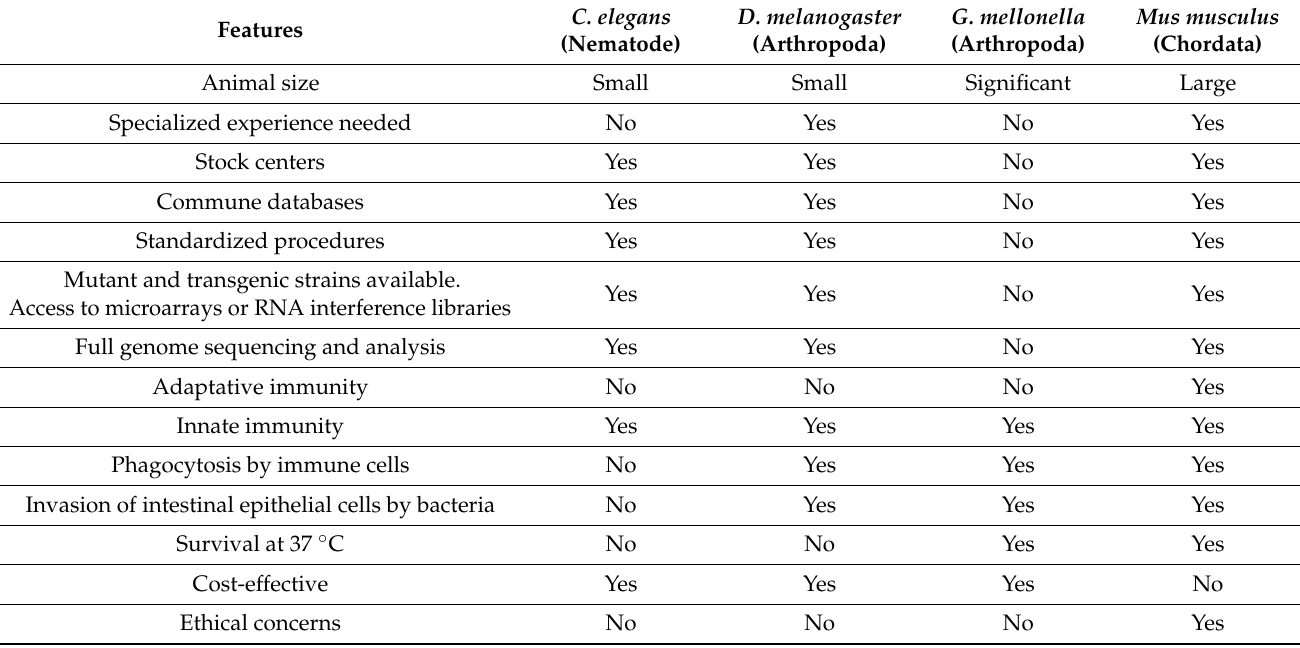
Table 4. Comparison between major invertebrate and mammalian